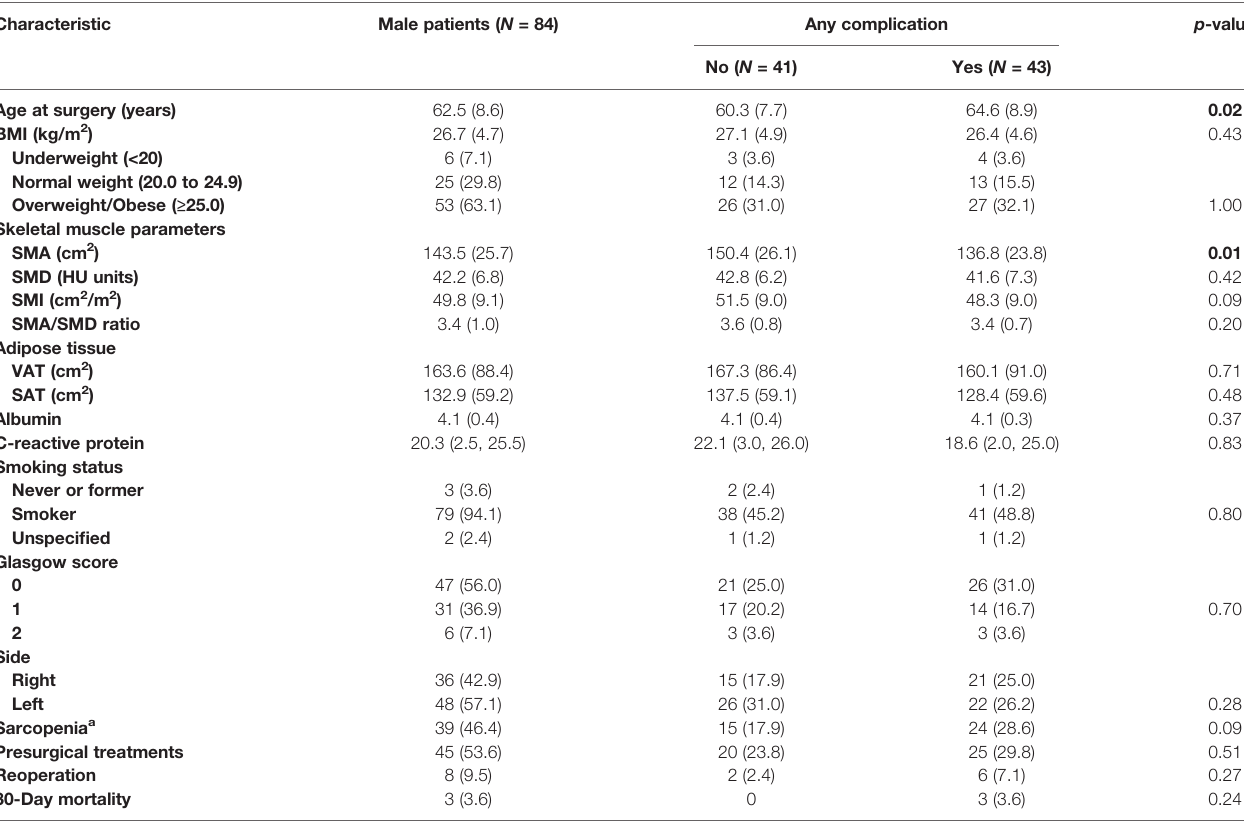
TABLE 3 | Patient characteristics and outcomes by complication (any) in male patients.